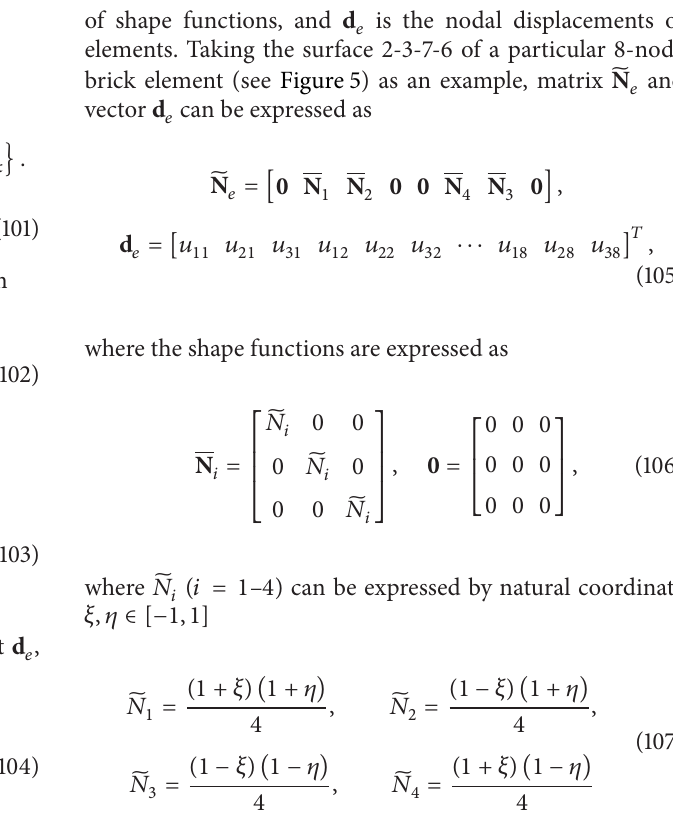
∗ ( x , y ) are given 𝑖𝑗𝑘